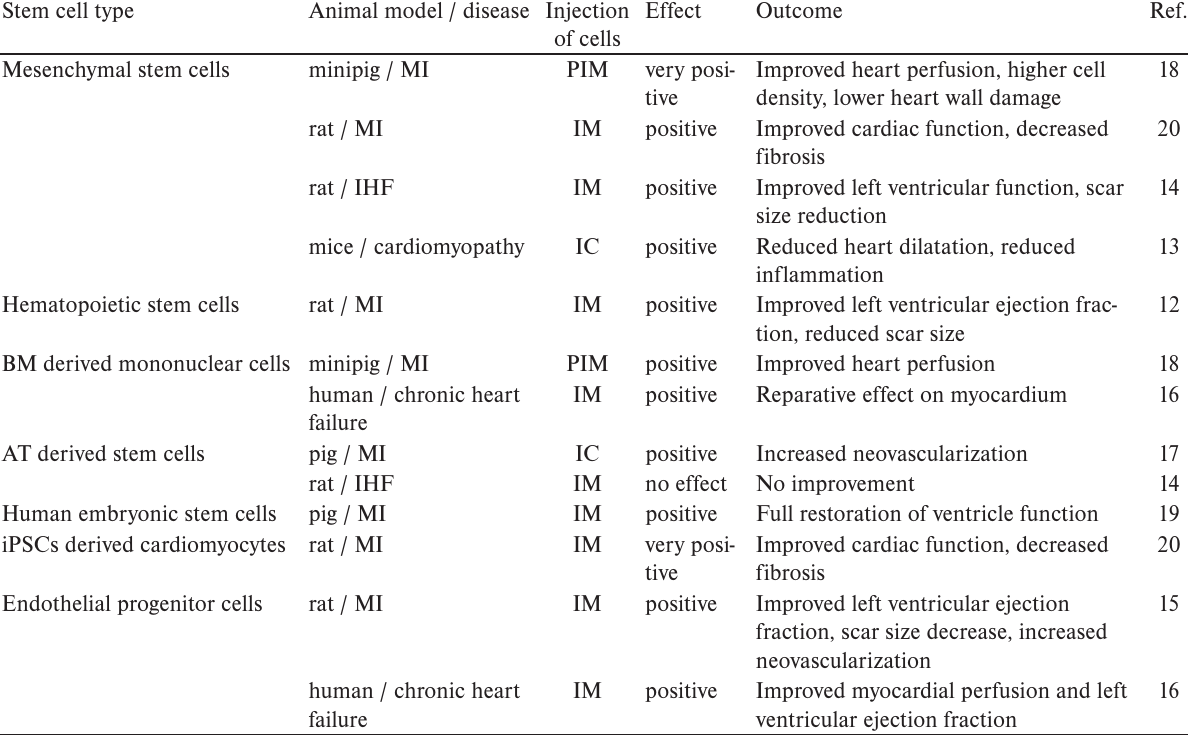
Table 1. Overview of stem cell types investigated for cardiac tissue repair. Stem cell